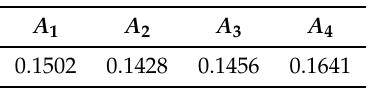
Table 12. The combined BPAs of the